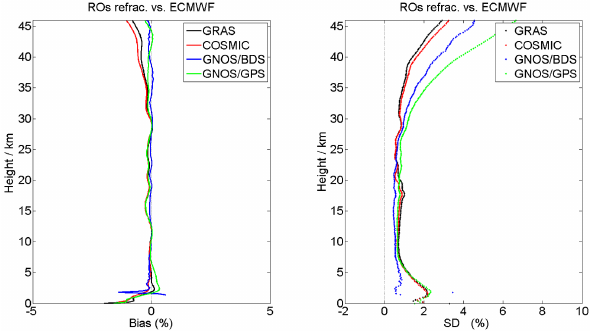
Figure 6. Comparisons of GNOS GPS, GNOS BDS, COSMIC, and MetOp/GRAS with ECMWF reanalysis in terms of refractiv- ity (from 1 November to 31 December 2013). The left panel is the mean bias of different RO data vs. ECMWF reanalysis, and the right panel is the standard deviation for each RO data.